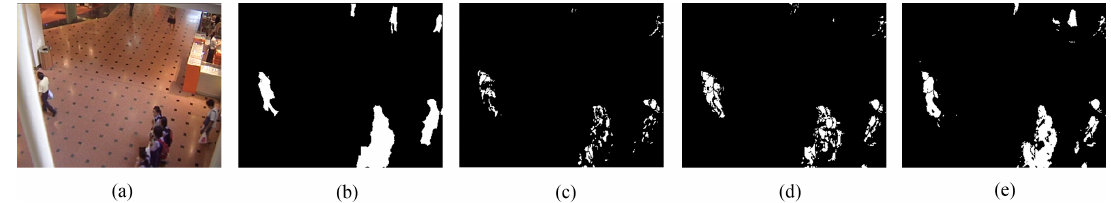
Figure 4. Our detection results of Frame 1780 of the shopping center sequence for J ranging from two to four: ( a ) input frame; ( b ) ground-truth reference; ( c ) result when J = 2; ( d ) result when J = 3; ( e ) result when J = 4.